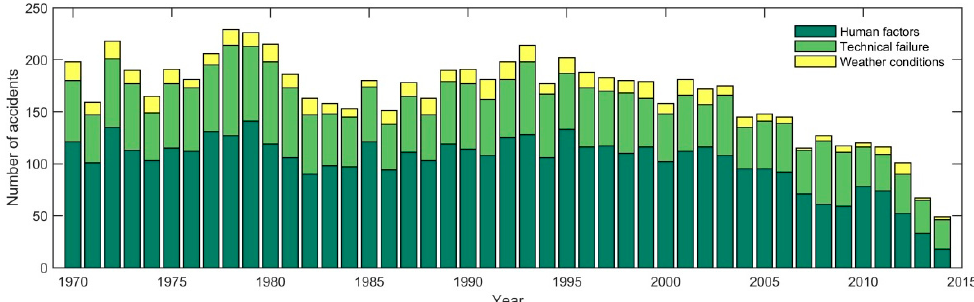
Figure 1. Aeronautical accidents from 1970 to 2014 with human factors, technical failure and weather conditions as contributory factors. Data retrieved from Bureau of Aircraft Accidents Archives (www.baaa-acro.com).